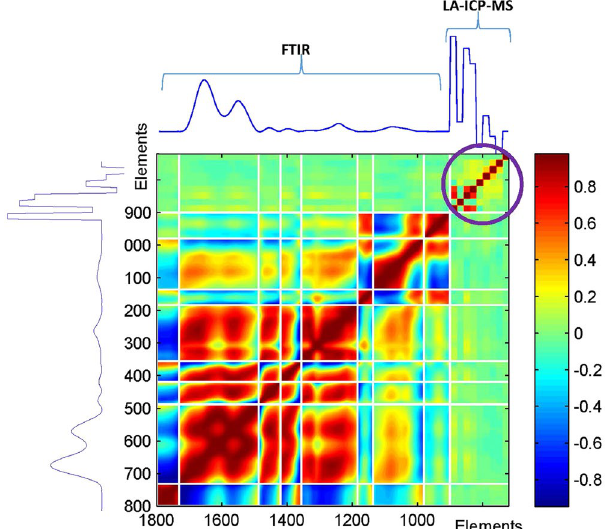
Figure 9. Correlation analysis of the FTIR/LA-ICP-MS concatenate spectra. The LA-ICP-MS data are represented by 9 points present below 900 cm − 1 as indicated by the purple circle. Elements are in the same sequence as previously: 13 C, 31 P, 34 S, 52 Cr, 55 Mn, 56 Fe, 58 Ni, 63 Cu and 64 Zn. The white line present on the figure corresponds to points of the spectra where there is no variance because a baseline has been drawn.